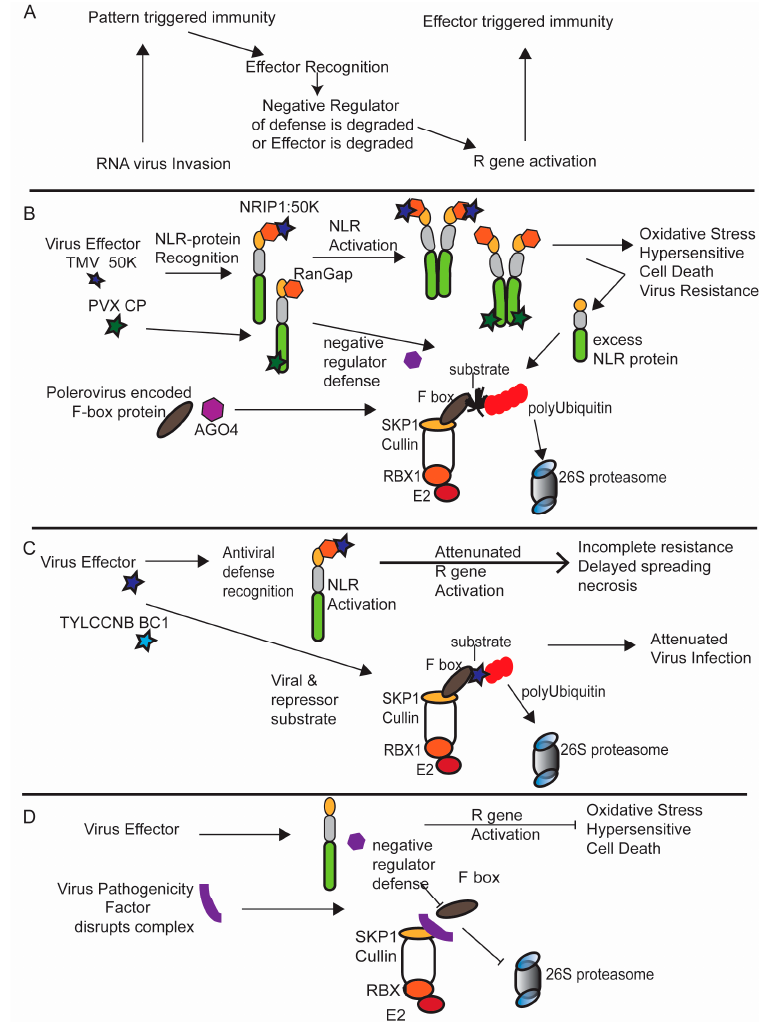
Figure 2. Diagrammatic representation of viral protein interactions with the UPS with respect to the molecular arms race; ( A ) zig ‐ zag model demonstrating the co ‐ evolution of viruses with pathogen associated molecular patterns (PAMP) ‐ triggered immunity (PTI) and effector ‐ triggered immunity (ETI); ( B ) two examples of tobacco mosaic virus (TMV) and potato virus X (PVX) effectors that activate N ‐ protein or Rx ‐ protein (NLR proteins) leading to activation of ETI and a hypersensitive cell death. With respect to N ‐ protein mediated resistance, nuclear receptor interaction protein (NRIP) is a co ‐ factor that binds the viral 50K effector. The co ‐ factor for Rx is Ran–Gap. Activation of the respective NLR proteins involves effector recognition, followed by dimerization or oligomerization. This is followed by oxidative stress, hypersensitive response and virus resistance. This model suggests that unknown factors that may serve as a negative regulator of the NLR protein, which blocks autoactivation, may be relayed to the SCF complex for ubiquitination and 26S proteasome degradation. In which case, the SCF complex is central to regulating NLR protein activation. Another method for protecting the cell from auto ‐ activation involves routine turnover of NLR proteins that may be excessive or have completed the necessary activation of defense responses. With regard to PTI, poleroviruses encode an F ‐ box protein that binds to Argonaute 4 (AGO4), relaying it to the SCF complex for ubiquitination and degradation. This serves to compromise PTI; ( C ) a proposed model for degradation of viral effectors by the SCF complex or ERAD machinery to evade immune recognition; and ( D ) certain viruses are known to interact with S ‐ Phase Kinase ‐ Associated Protein 1 (SKP1) but do not appear to function as F ‐ box proteins. One possibility is that these proteins insert into the SCF complex and disrupt its ability to function in the degradation of negative regulators of defense as in panel A. In this scenario, the immune system may be blocked.